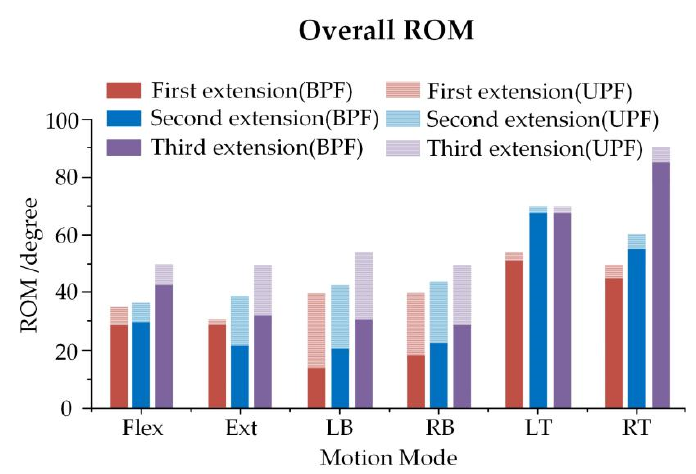
Figure 11. Overall ROM of the spine in the three growth periods. Bracing force is defined as an index that measures whether the rod will break